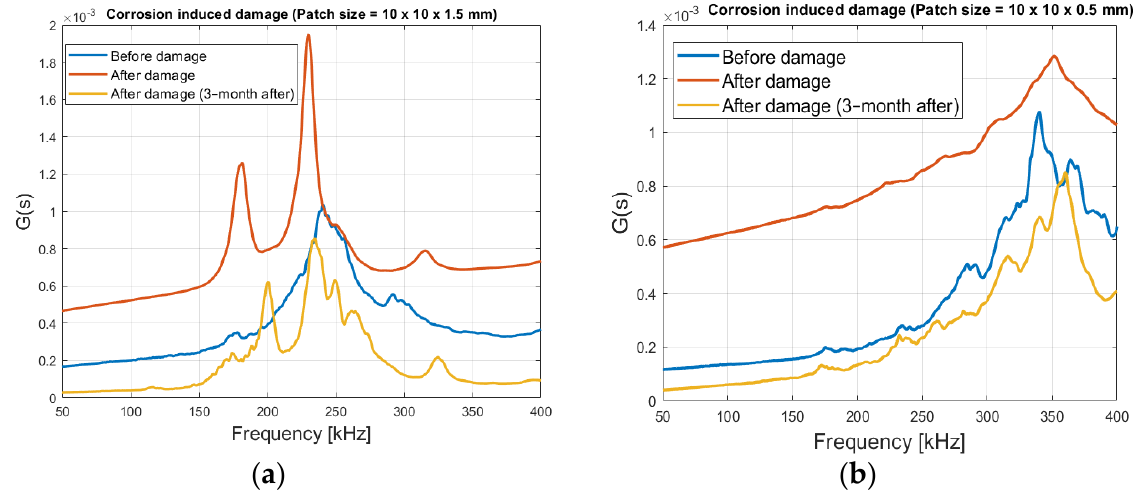
Figure 18. Before damage and damage signature in RC, steel size = 200 mm × 16 mm. ( a ) Patch size = 10 × 10 × 1.5 mm, and ( b ) Patch Size = 10 × 10 × 0.5 mm.